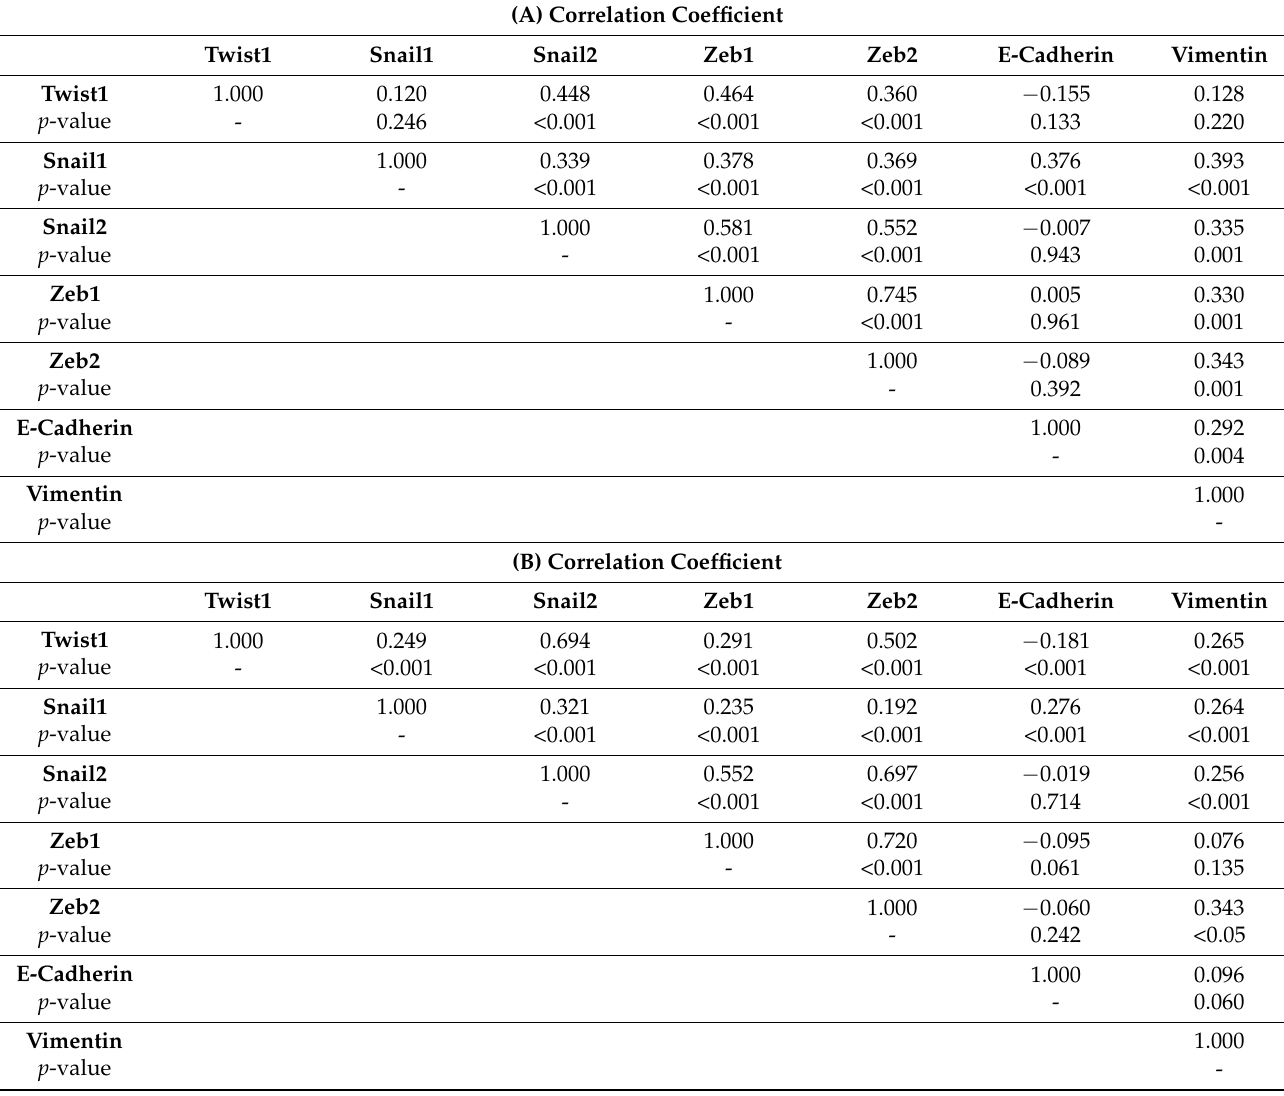
Table 2. Correlation analysis among the expression levels of the EMT transcription factor, E-cadherin, and vimentin from the present case study consisting of 95 PTCs ( A ) or from the TGCA case study consisting of 388 PTCs ( B ). Correlations among all the mRNAs were evaluated using the Spearman’s Rho